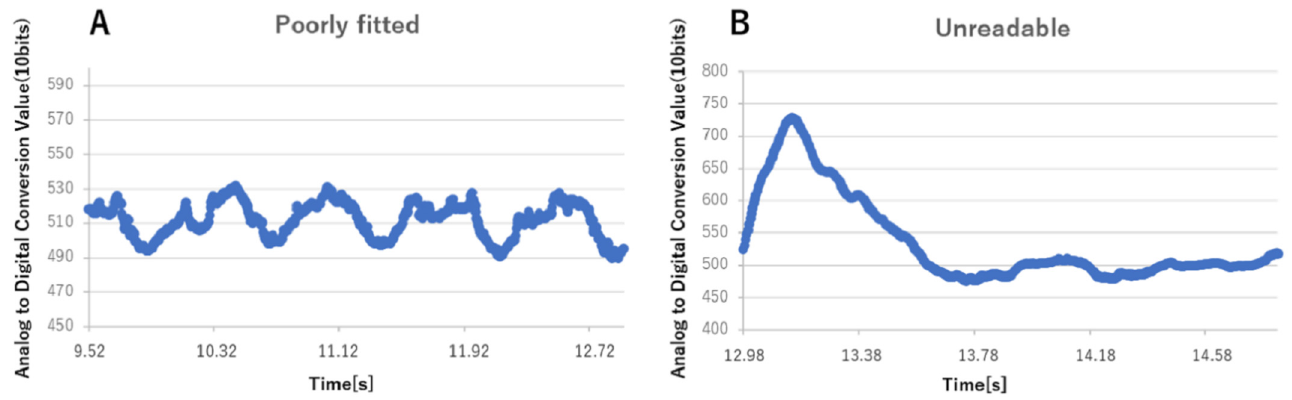
Figure 4. An example of a waveform left out of analysis. ( A ) Poor sensor mounting (subject No. 2), ( B ) Indiscernible data (subject No. 4).